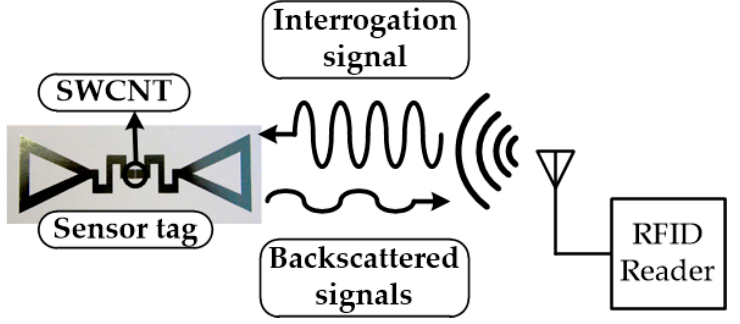
Figure 11. Operation principle of an RFID-enabled gas sensor utilizing single wall carbon nanotubes